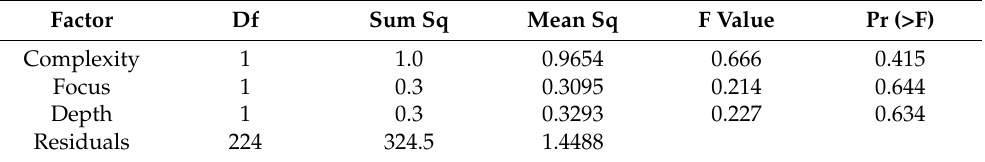
Table 2. ANOVA analysis for the MOS scores with various